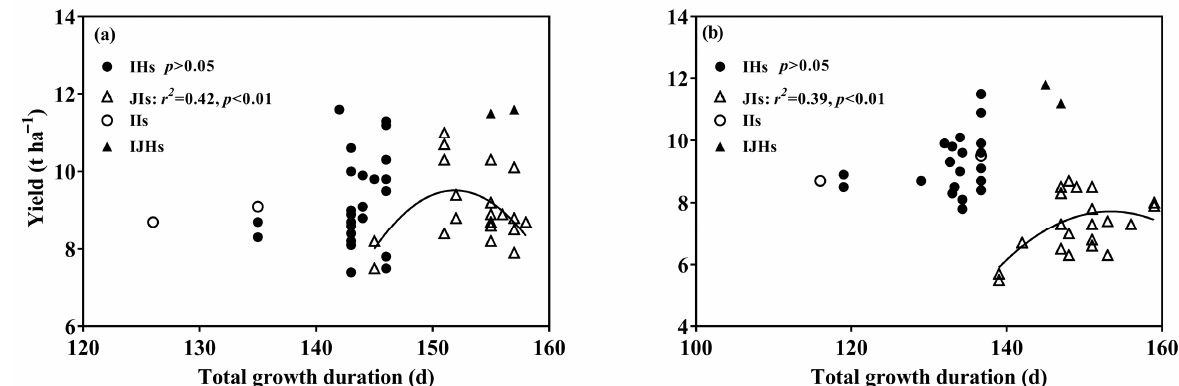
Figure 5. Relationship between yield and total growth duration in 2017 ( a ) and 2018 ( b ), respectively. IJHs, indica-japonica hybrids; IHs, indica hybrids; JIs, japonica inbreds; IIs, indica inbreds. p < 0.01, significance at the 0.01 probability level according to the LSD